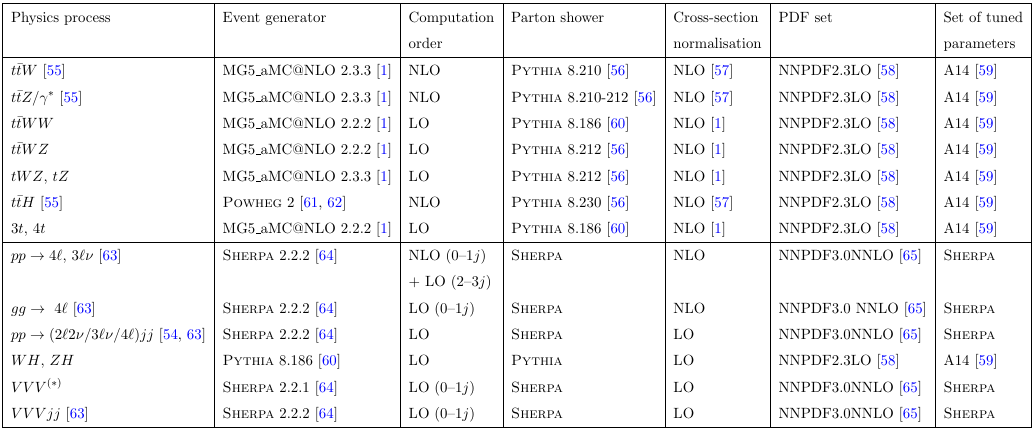
Table 2. List of Monte Carlo event generators and their settings used to predict the contributions from SM processes to the various regions of interest in the analysis. When no reference is provided for the cross-section normalisation, the one computed by the generator is used. The LO and NLO acronyms are de(cid:12)ned in section